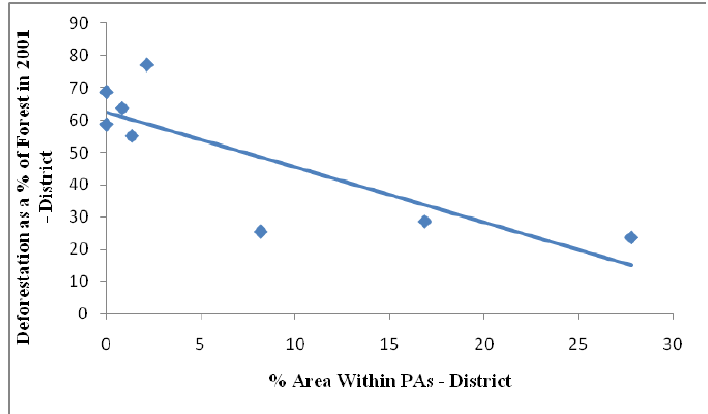
Figure 16a. Relationship between percentage of area within PAs and the distribution of deforestation as a percentage of the forest area existing in 2001, for districts.